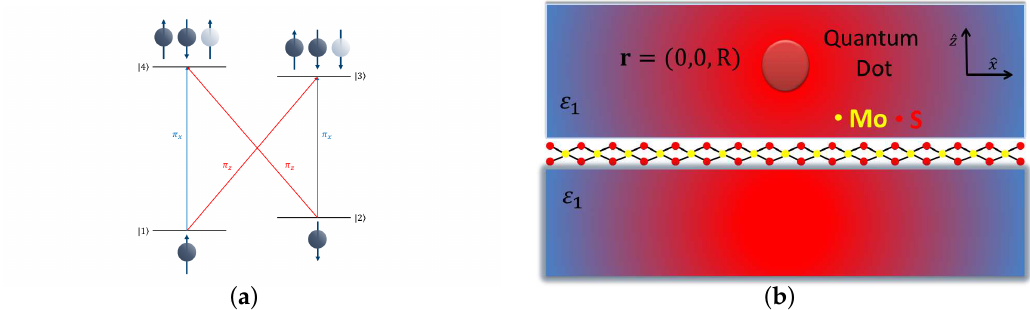
Figure 1. ( a ) A structure of the energy levels for a QD in the Voigt configuration. ( b ) A schematic of the system under study, where the QD is placed at distance z = R on top of a MoS 2